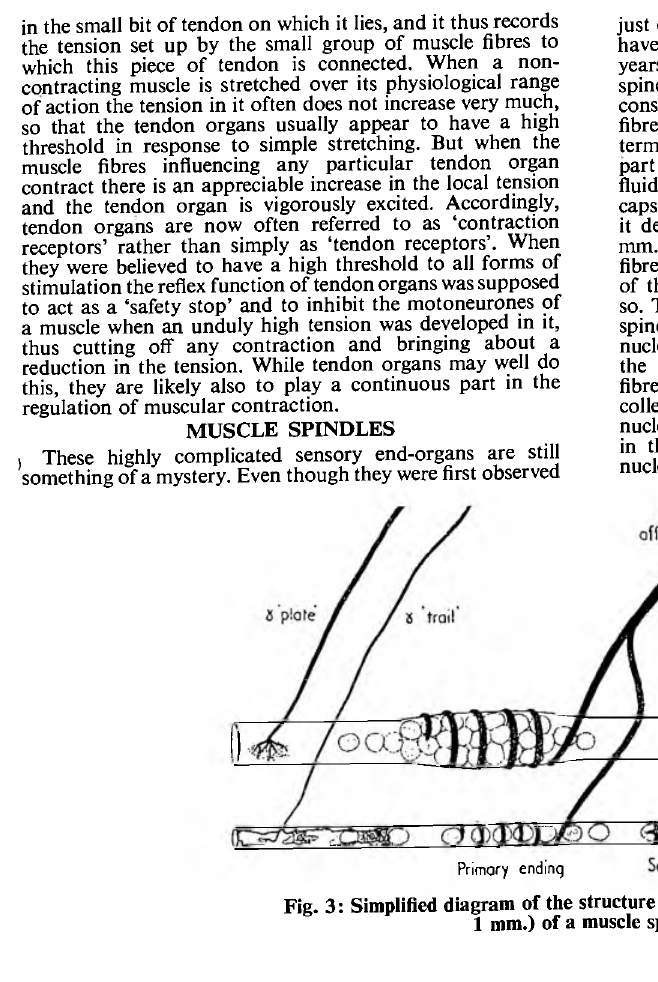
Fig. 3: Simplified diagram of the structure of the central region (about 1 mm.) of a muscle